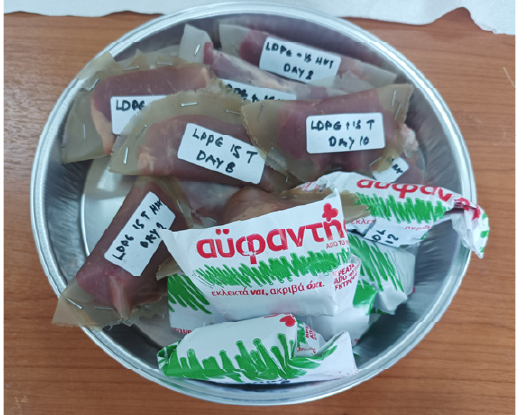
Figure 1. “Scaloppini” type fresh pork fillets after folded in LDPE or LDPE/xHNT